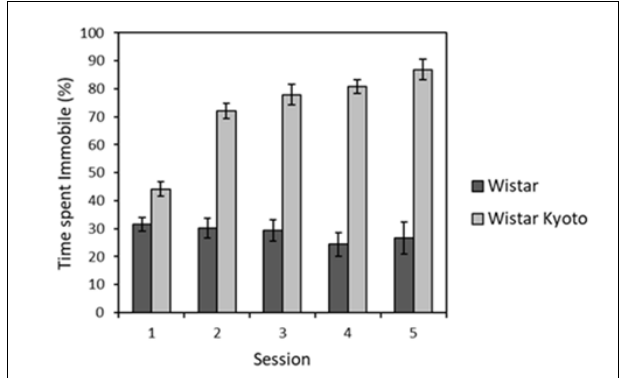
FIGURE 1 | Mean percentage of time immobile ( ± SEM) during 2 min brief swim sessions for animals subjected to mild stressor protocols (Wistar: dark bars; WKY: light bars). WKY rats were significantly more immobile than Wistar rats, and the levels of immobility significantly increased across sessions in WKY but not Wistar rats (see “Stress Manipulation and Brief Swim” section, for details). See Supplementary Table S2 for the timing of these sessions relative to the other experimental